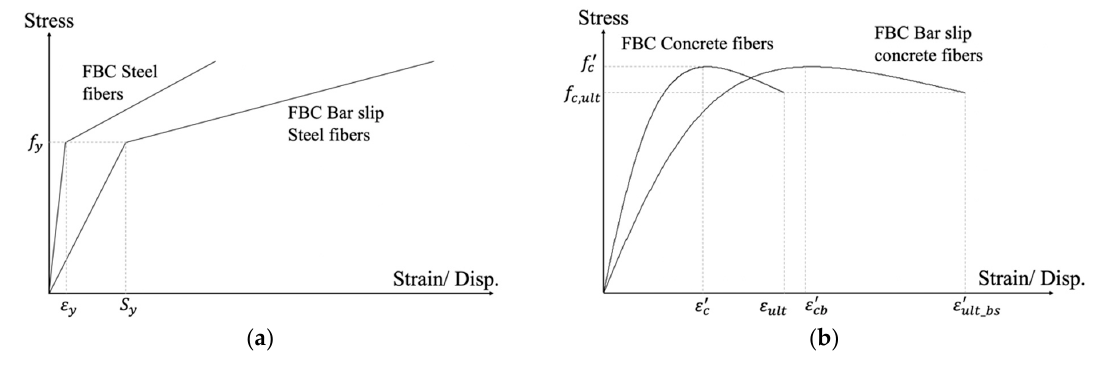
Figure 13. Fiber stress-strain relations: ( a ) steel; ( b ) concrete